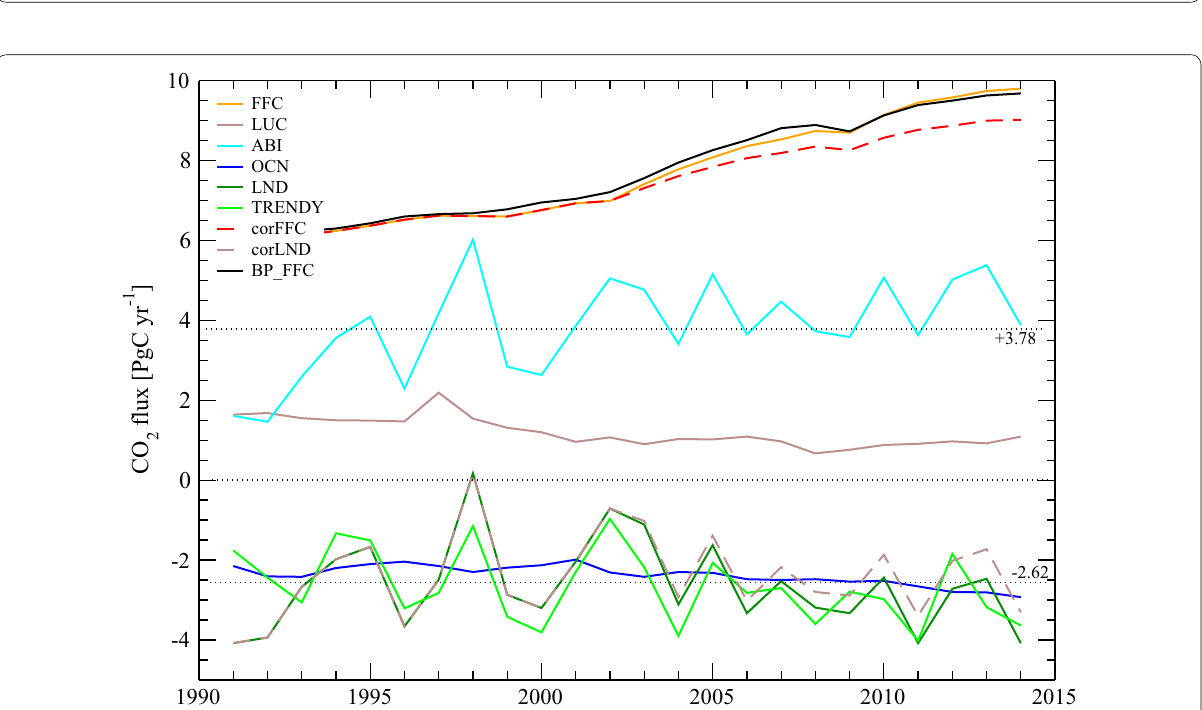
Fig. 7 Time series of CO 2 fluxes as estimated by the Global Carbon Project for fossil fuel and cement (FFC), land-use change (LUC), atmospheric burden increase (ABI), oceanic exchange (OCN), residual land biosphere (LND FFC LUC – ABI OCN), ensemble mean land fluxes simulated by = + − the global dynamic vegetation models (from TRENDY project). FFC corrected by CH 4 inversion scaling (corFFC) are also shown in comparison with recent update of British Petroleum (BP) emission inventory of global totals. Corrected land fluxes (corLND) is based on residuals calculated using corFFC emissions. Three horizontal dotted-lines at 2.62, 0 and 3.78 PgC are marked for easy reference to the flux −